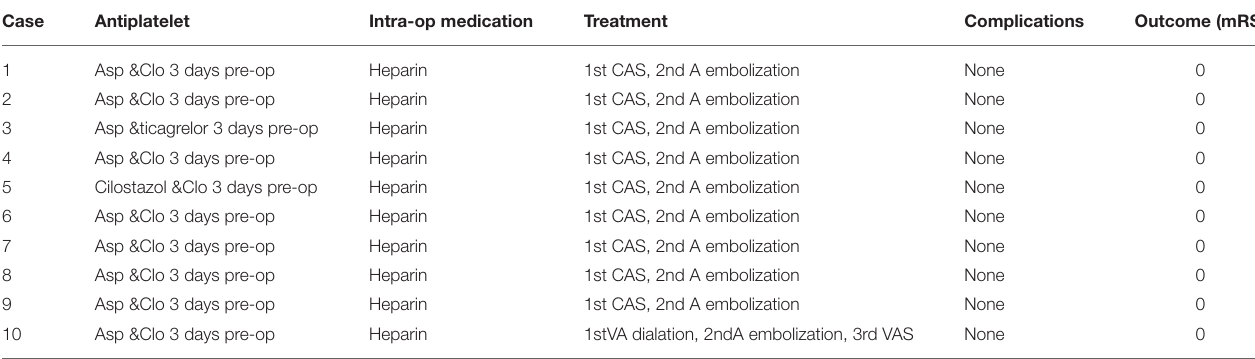
TABLE 3 | The treatment and the outcome of our case series.